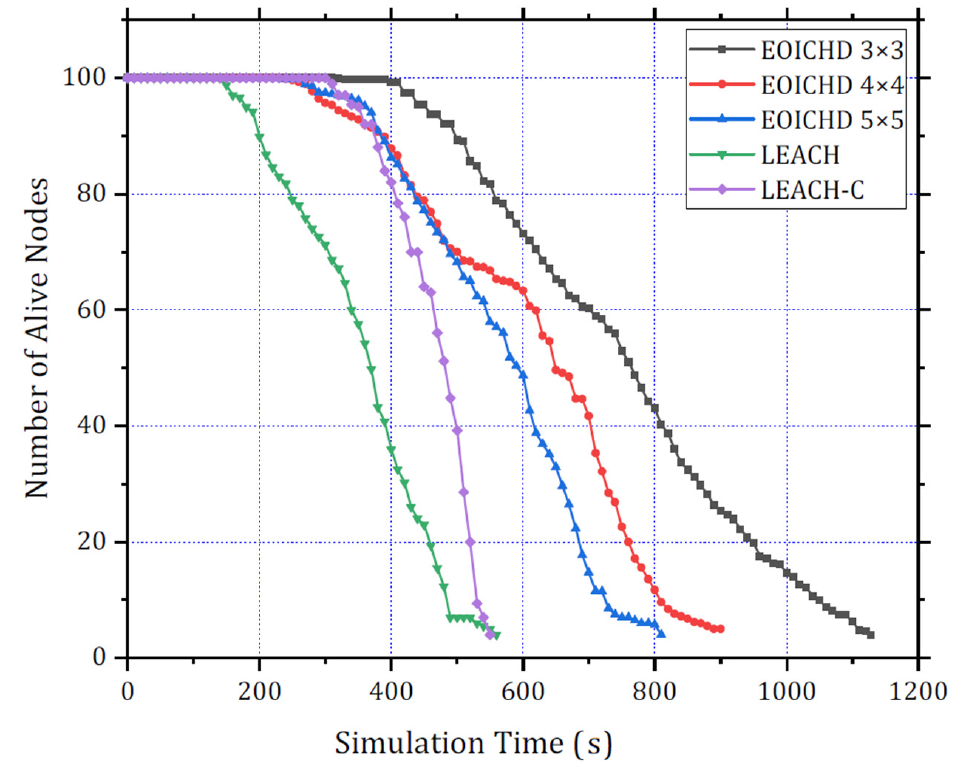
Figure 7. Number of alive nodes over simulation period Scenario